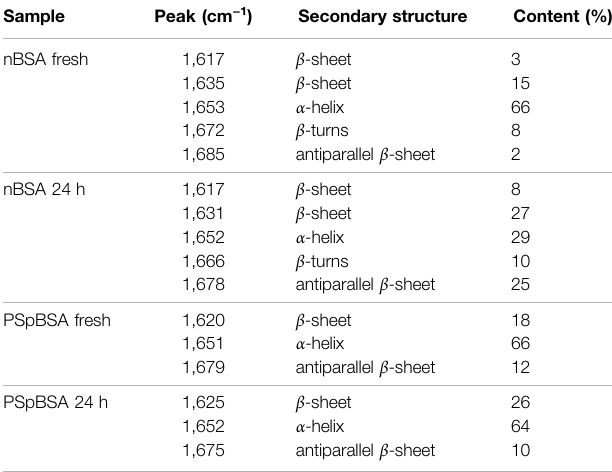
TABLE 1 | Secondary structural content analysis from the deconvoluted FT-IR spectra (3) of protein solutions. Sample Peak (cm − 1